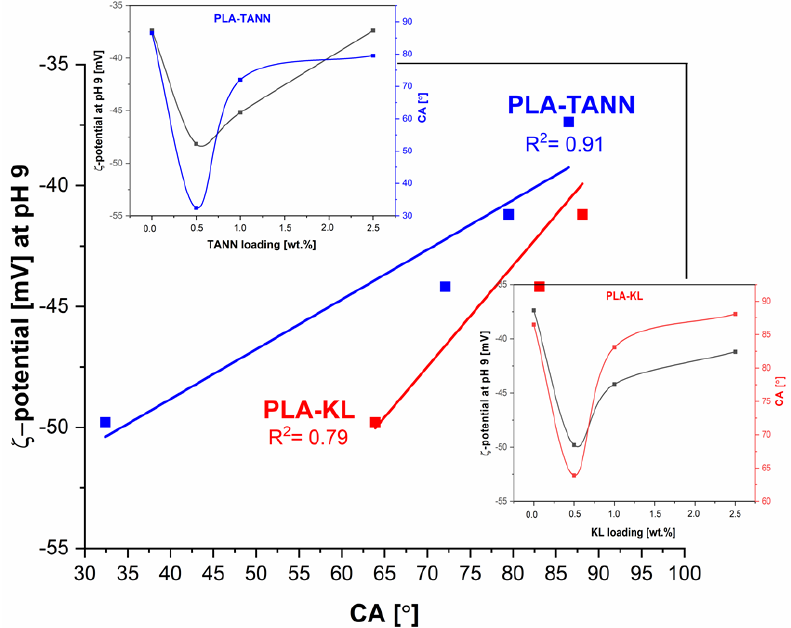
Figure 6. The correlation between the plateau zeta potential at pH 9 and polyphenolic filler loading in PLA-KL and PLA-TANN composites. The insets show the dependence on CA, zeta potential at pH 9, and polyphenol loading.